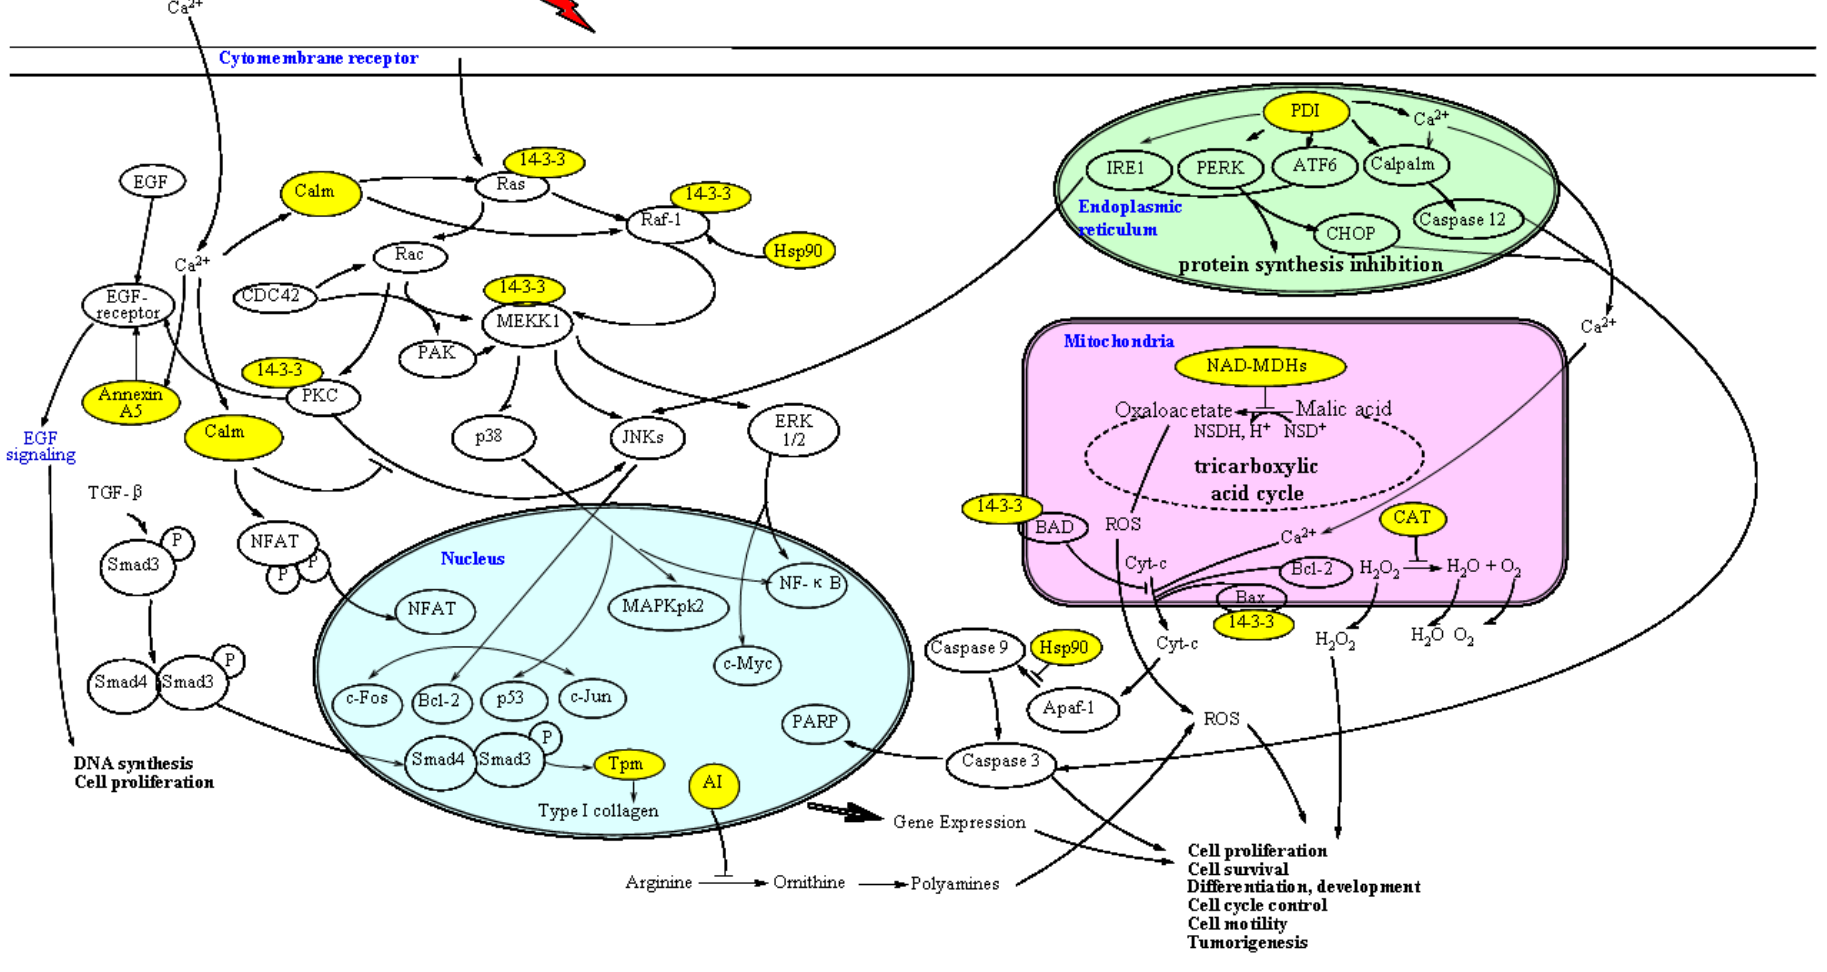
Figure 7. The inhibition pathway of 5'-AMP to cell apoptosis induced by γ -ray